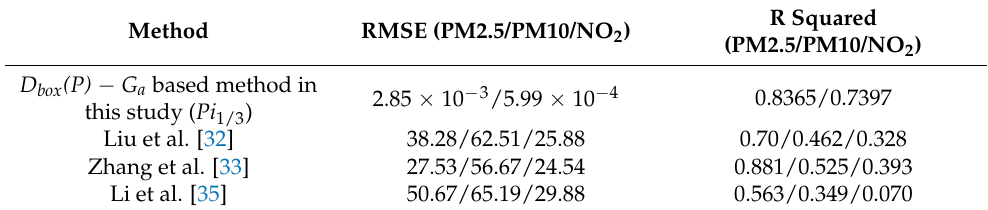
Table 4. Comparation of calculation methods.